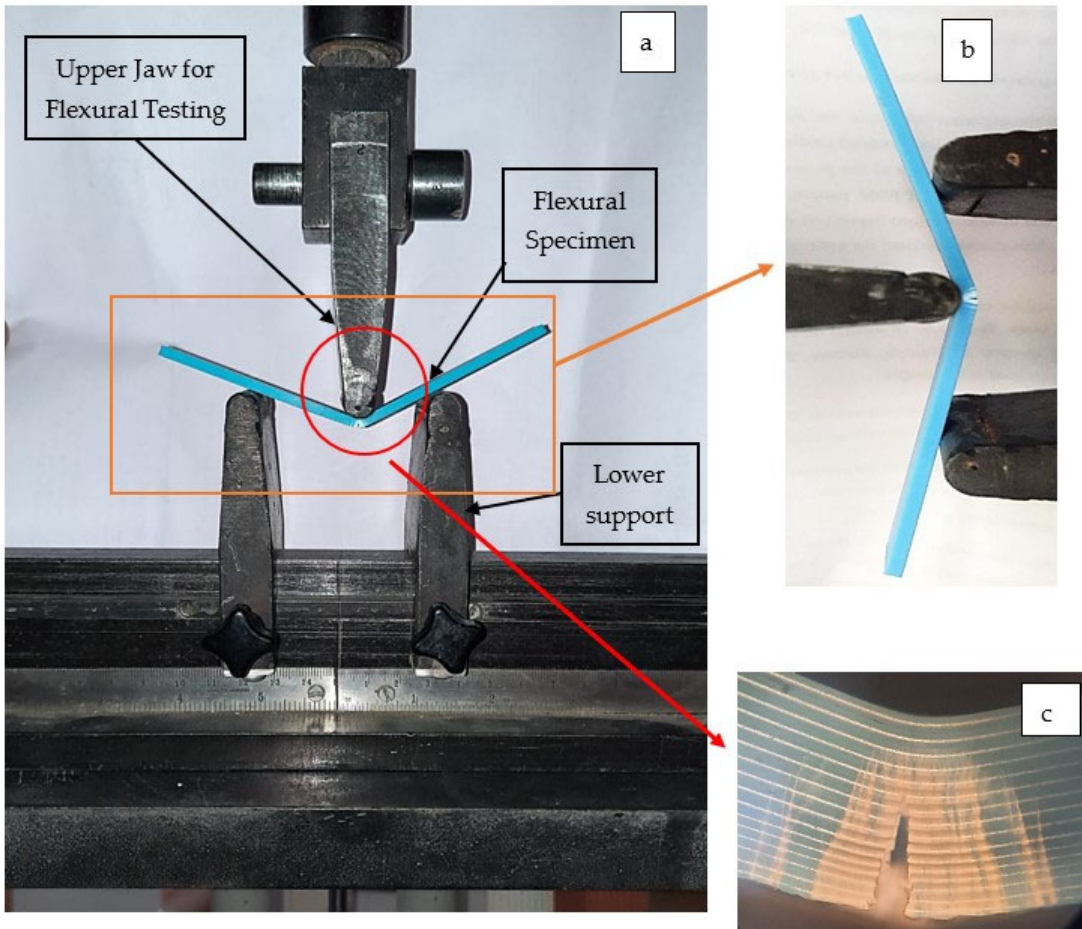
Figure 4. ( a ) UTM setup for testing for flexural specimen using ASTM D790 standard, 4 ( b ) focused area under flexural testing, and 4 ( c ) magnified image for the fractured area of ABS specimen.